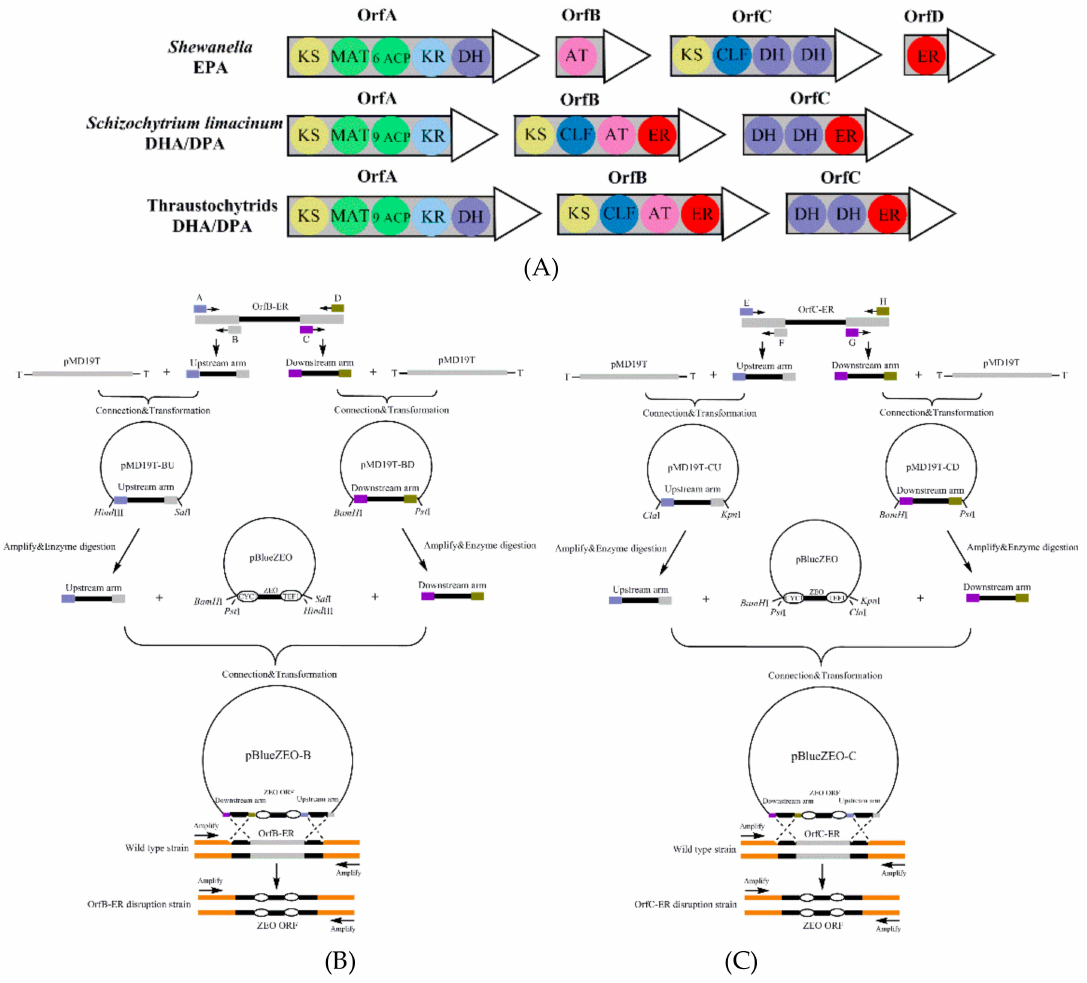
Figure 1. ( A ) Examples of polyunsaturated fatty acids (PUFAs) synthase organization in various representative organisms. KS: β -ketoacyl synthase; MAT: malonyl-CoA:ACP transacylase; ACP: acyl-carrier protein; KR: β -ketoreductase; DH: dehydratase; CLF: chain length factor; AT: acyl transferase; ER: enoyl-reductase; DH: dehydratase. ( B ) Construction of OrfB-ER gene konckout vector; ( C ) construction of OrfC-ER gene konckout